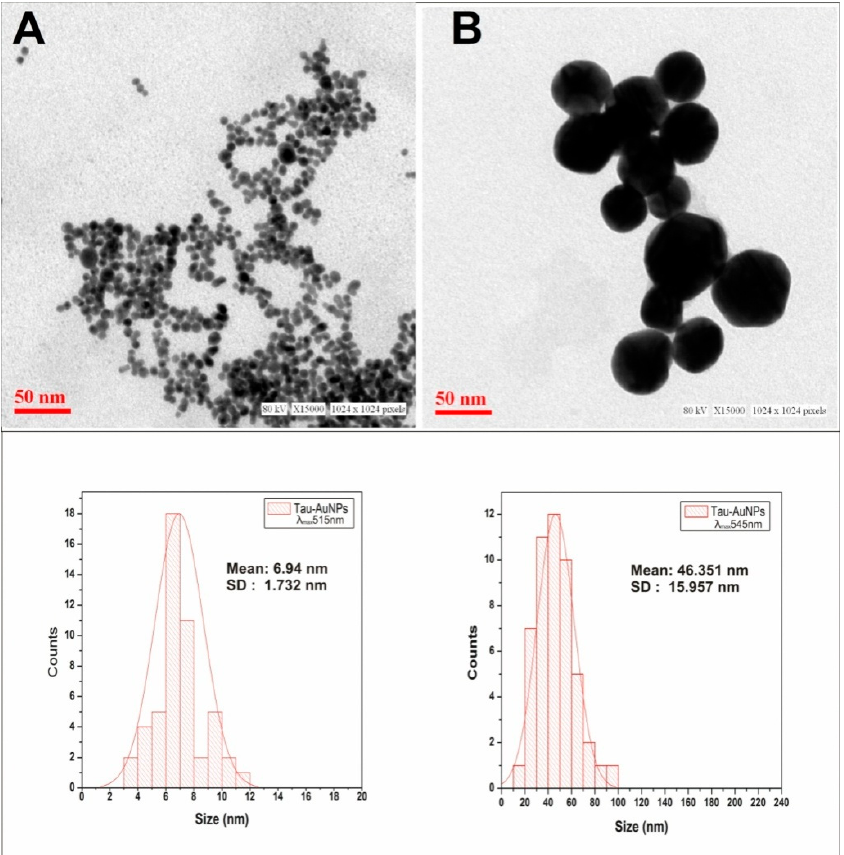
Figure 5. Electron microscopy for the visualization and size estimation of the taurine-capped gold nanospheres: Taurine-capped AuNPs with λ max 515 nm had an average diameter of 6.9 nm, as shown in ( A ). Taurine-capped AuNPs with λ max 545 nm had an average diameter of 46 nm, as shown in ( B ). Spherical shapes were observed for the samples, which were monodisperse. The inset Gaussian curve represents the mean size (50 nanoparticles per sample from TEM images were measured for statistics) of the gold nanospheres.